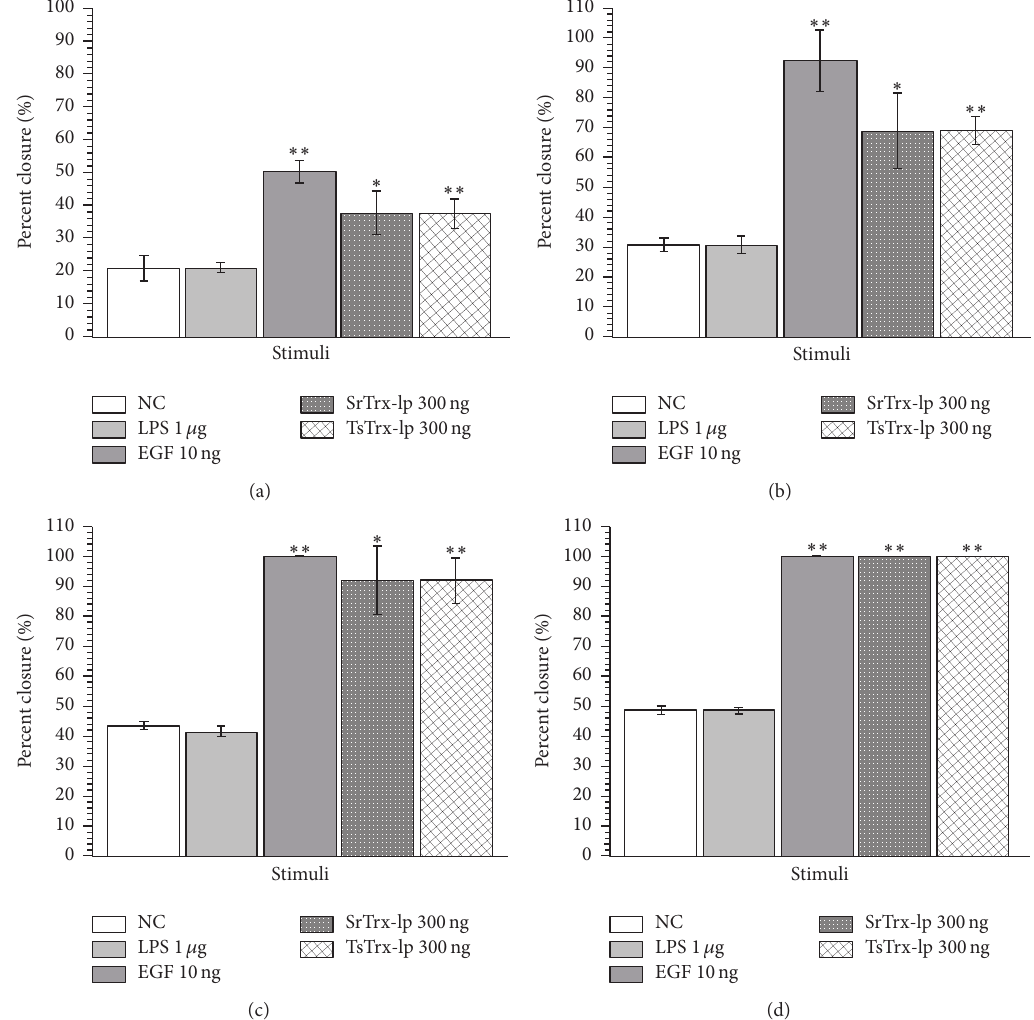
Figure 8: Percentage closure of the Caco-2 wound gap after 24 h (a), 48h (b), 72 h (c), and 96h (d). In general, the gap was narrowed by approx. 10–15% every day adding no stimulus. As a negative control, cells were observed without any stimulus (NC) and with LPS (1 𝜇 g). As a positive control, epidermal growth factor (EGF) was used, whereat 10ng fostered wound healing the best. SrTrx-lp and TsTrx-lp were tested at different concentrations (3 ng, 30 ng, 300 ng, 1 𝜇 g, 10 𝜇 g, and 25 𝜇 g–each per 500 𝜇 L), here at 300 ng represented as the best wound healing promoting concentration. The wound healing process was highly significantly promoted by EGF and TsTrx-lp ( ∗∗ 𝑃 < 0.01 ) as well as significantly promoted by SrTrx-lp ( ∗ 𝑃 < 0.05